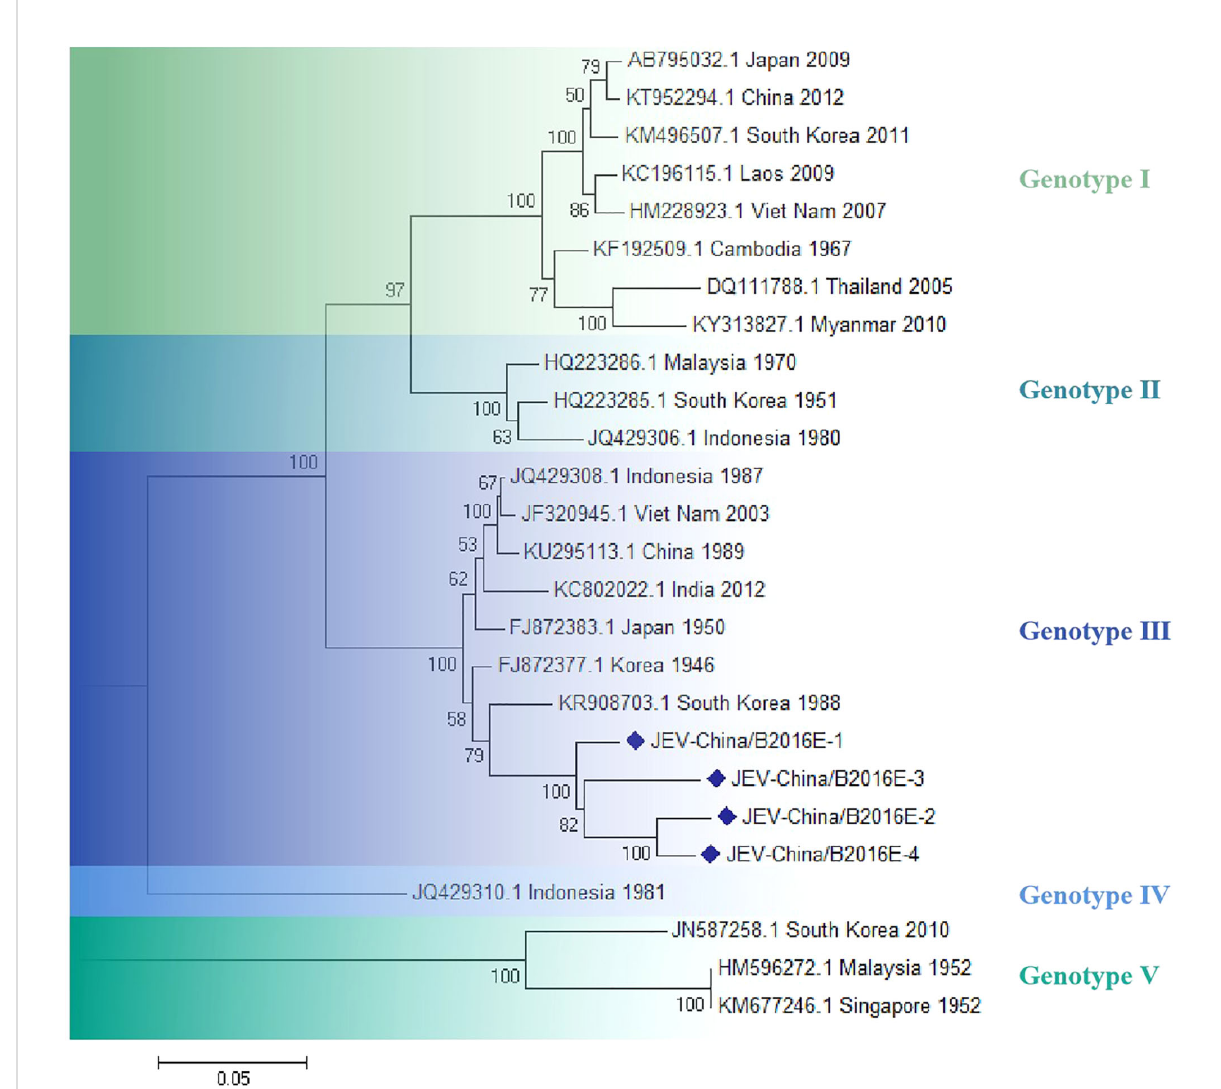
FIGURE 5 The phylogenetic analysis based on JEV-E. Complete E gene sequences with 1500 nt of JEV were used for phylogenetic analysis. The maximum likelihood method was used tree building algorithms in MEGA 7.0, with bootstrap value set to 1,000. Solid blue rhombus was used for marking the viral genes ampli fi ed in the